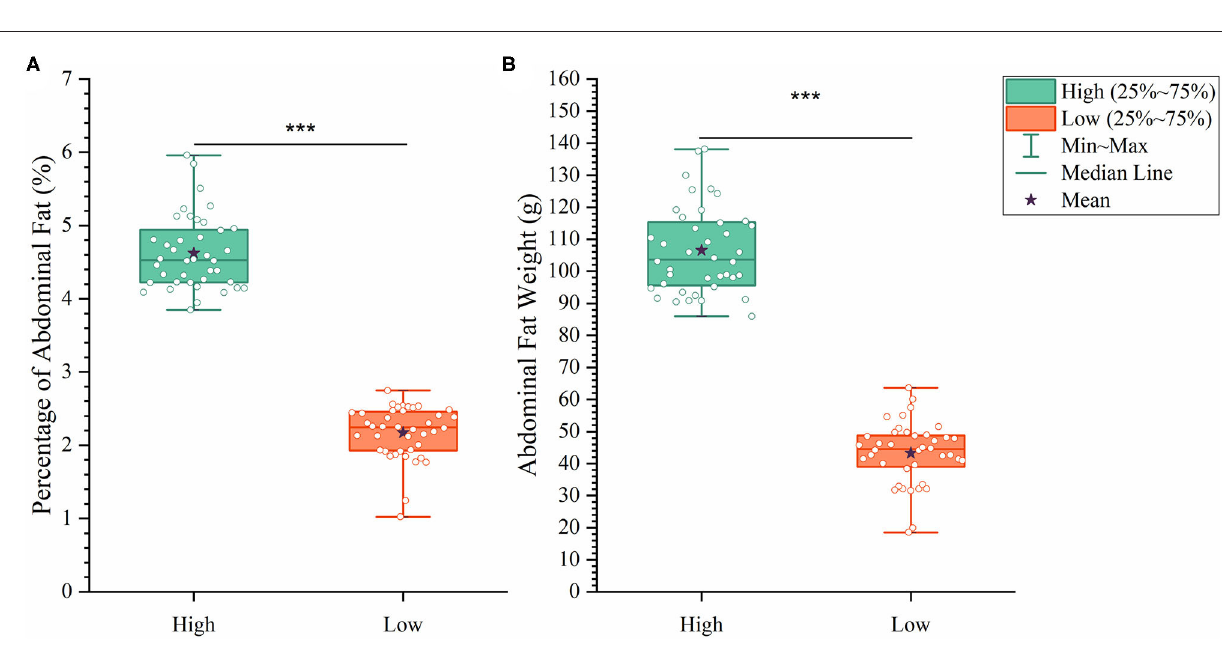
Ruminococcus_torques_group . As shown in Figure 7 , Treponema and Ruminococcus_torques_group abundances were significantly related to AFW ( P < 0.05). Furthermore, the 20% of ducks with the highest Treponema abundance tended to have a significantly lower AFP and BW than the 20% of ducks with the lowest Treponema abundance ( Figure 7A , P = 0.056 and